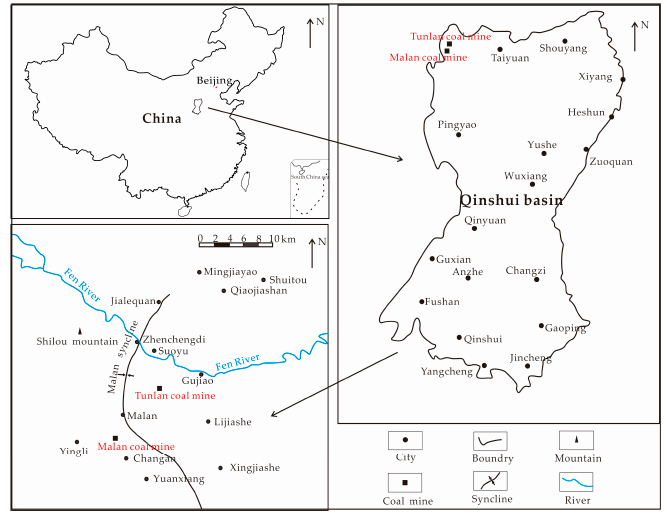
Figure 1. Location of sampling area.